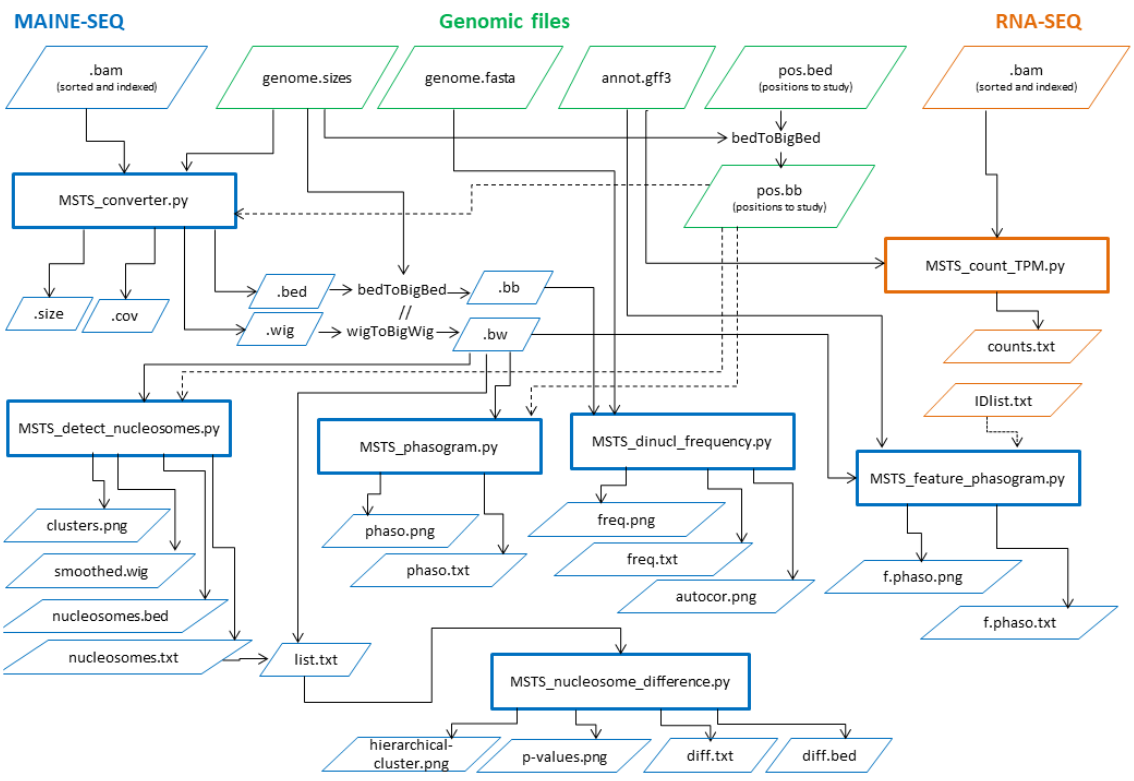
Supplementary Figure 1. Workflow of the MNase-Seq Tool Suite (MSTS). The MSTS tool allows combining MNase-seq and RNA-seq data analyses, perform simple statistics and plot results (Lapalu